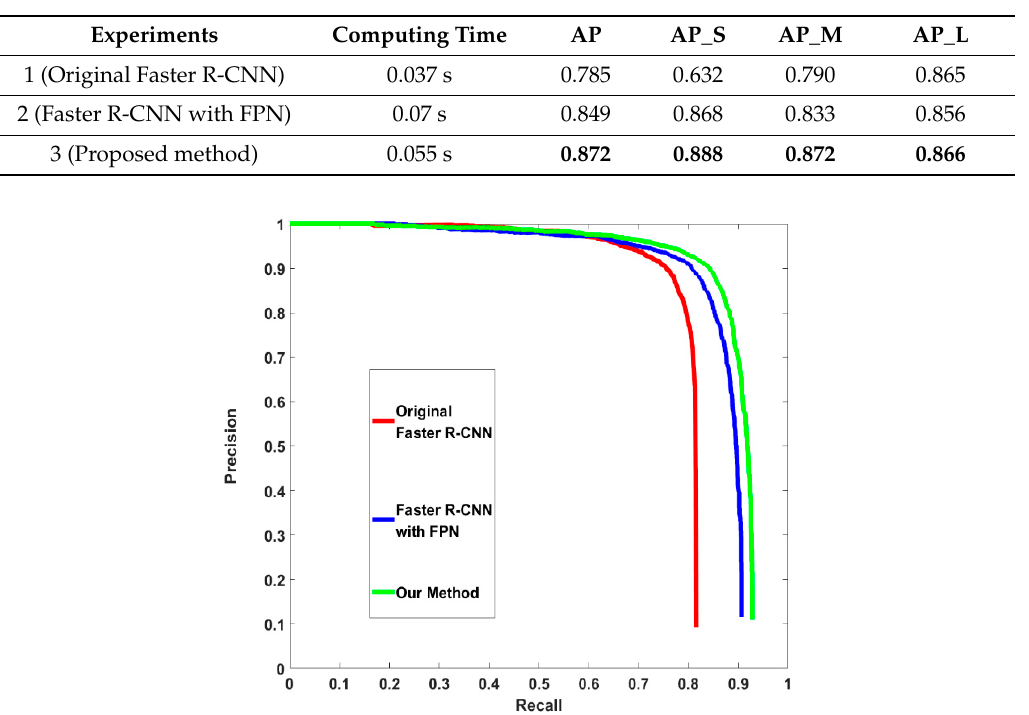
Table 5. Performance of final detection results in different experiments.